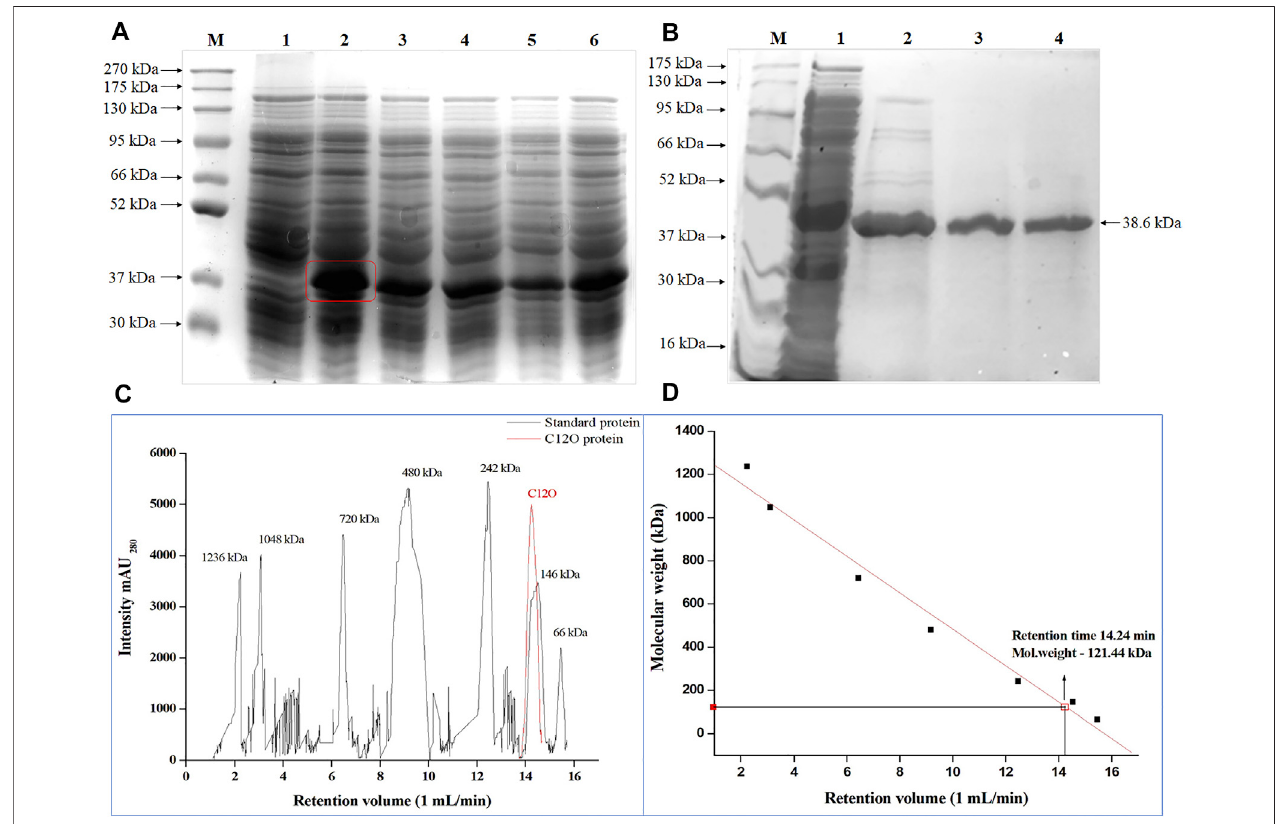
FIGURE 1 | Over-expression of C12O from Paracoccus sp. MKU1 in E. coli . (A) SDS-PAGE analysis of IPTG induced cell lysate. Lane M — Protein Ladder; Lane 1 — Uninduced; Lane 2 — 0.2 mM IPTG; Lane 3 — 0.4 mM IPTG; Lane 4 — 0.6 mM IPTG; Lane 5 — 0.8 mM IPTG; Lane 6 — 1.0 mM IPTG. (B) SDS-PAGE analysis of Ni- NTA columnpuri fi edrecombinantC12O protein after 0.2 mM IPTG induction. M — Marker,Lane 1 — Crudeextract,Lane2 — Eluate1, Lane3 — Eluate2, Lane4 — Eluate 3. (C) — Size exclusion chromatography analysis of puri fi ed of C12O and reference proteins. (D) Calibration graph for